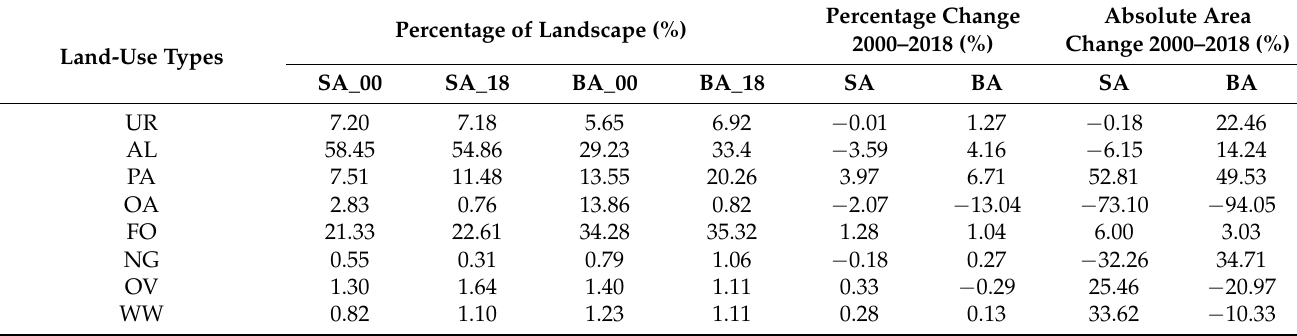
Table 7. Land-use change patterns in Saxony-Anhalt and Bavaria from 2000 to 2018.